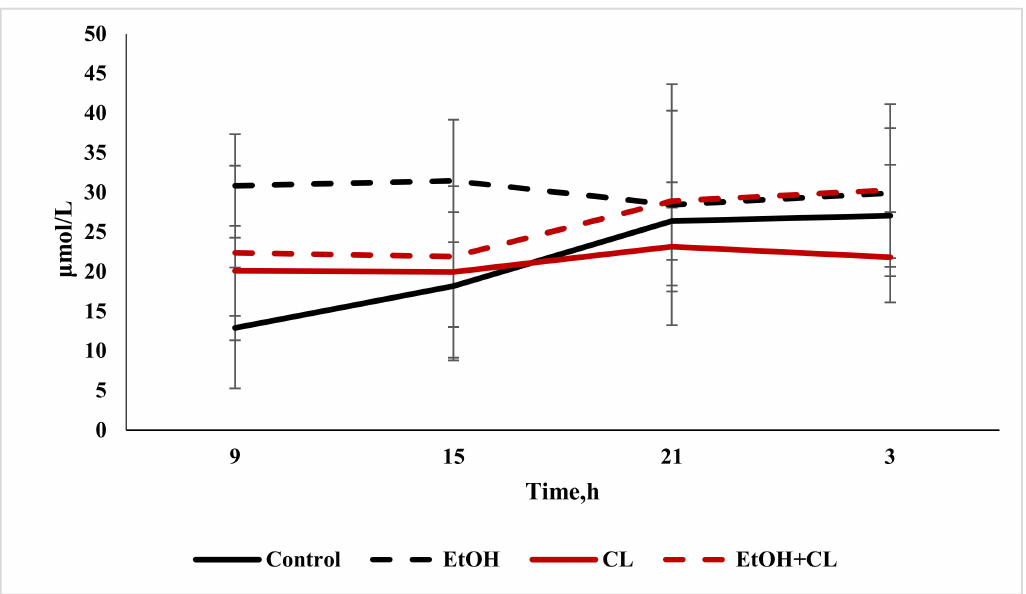
Figure 16. Daily fluctuations of total bilirubin in the blood plasma of rats.